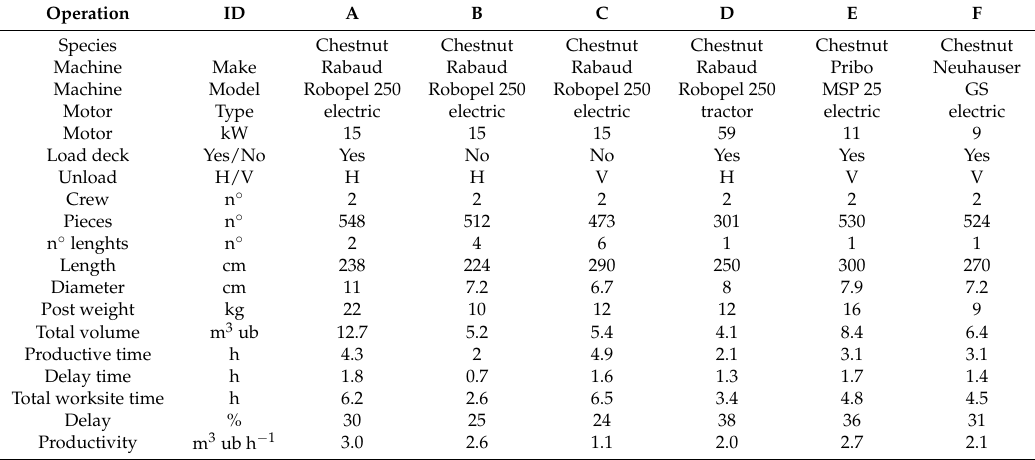
Table 1. Characteristics of the sample